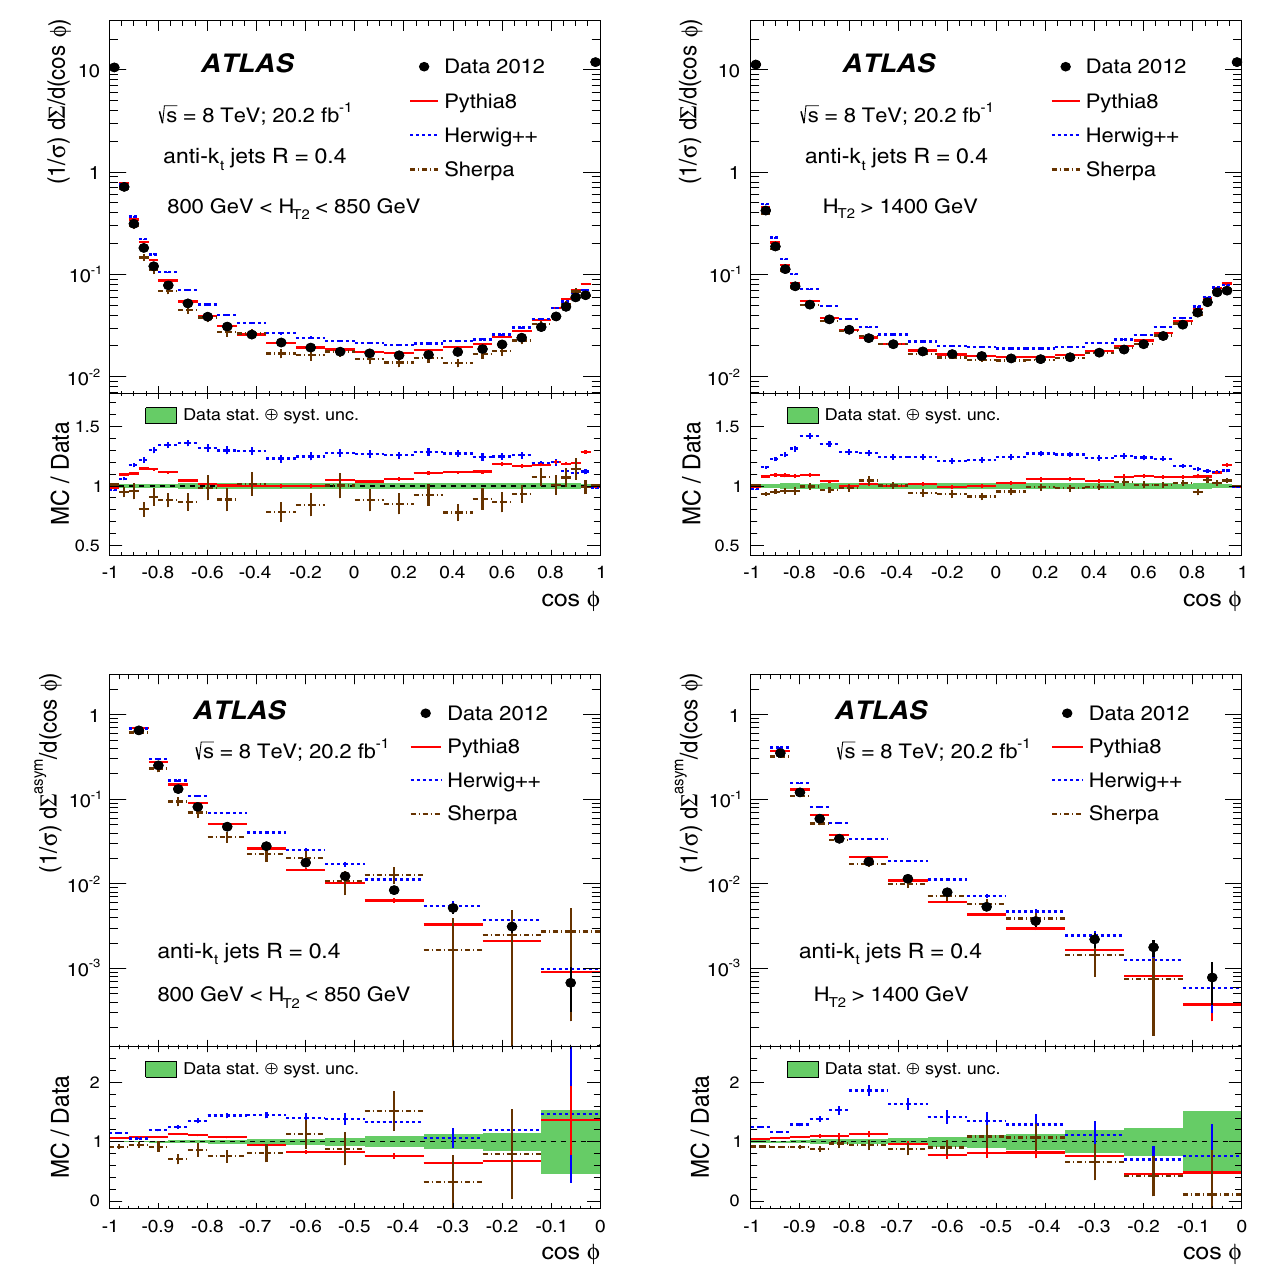
experimental sources, i.e. those not related to unfolding corrections, is alsoindicatedusinganerrorbarforthedistributionsandagreen-shaded band for the ratios. The systematic uncertainties are discussed in Sect.